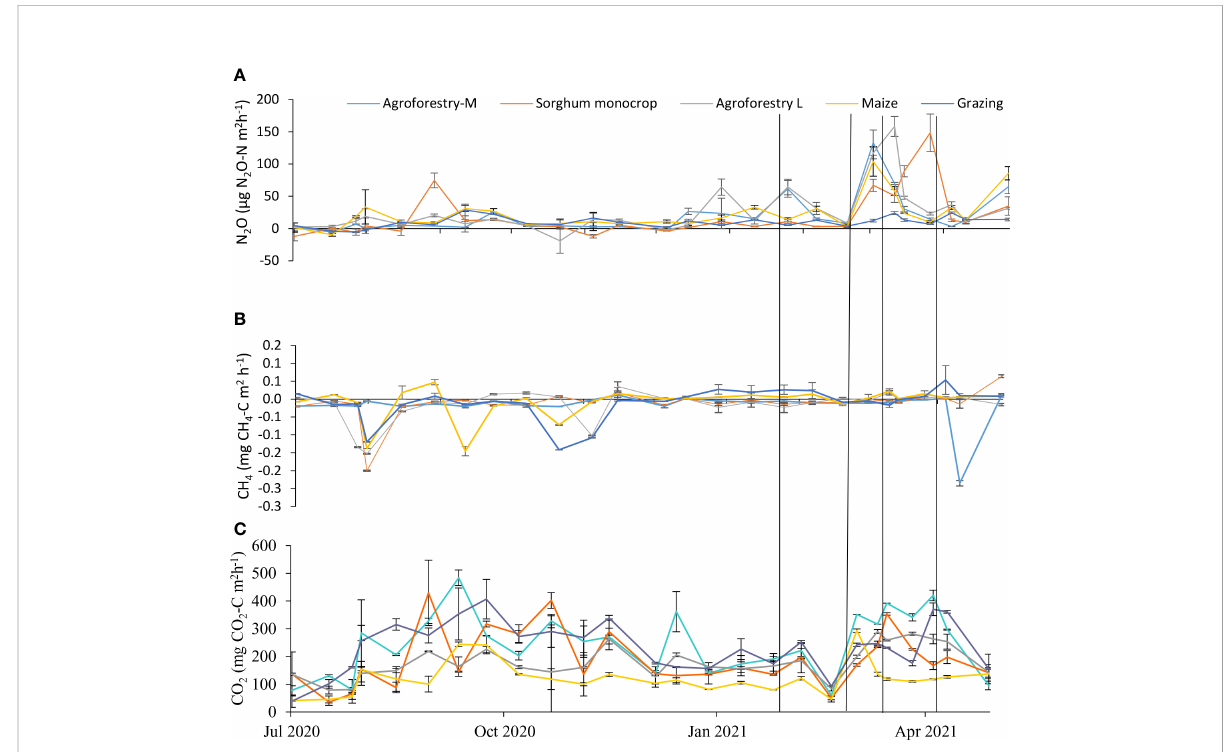
correspond to fl ooding days in different land utilization types in Siaya County,